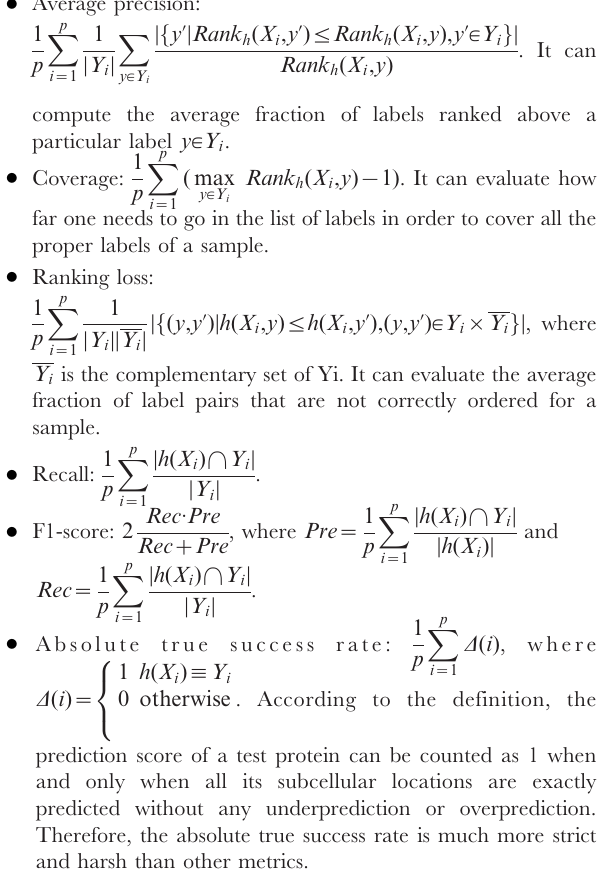
Table 3. Some examples of the experimental results outputted by the two algorithms.